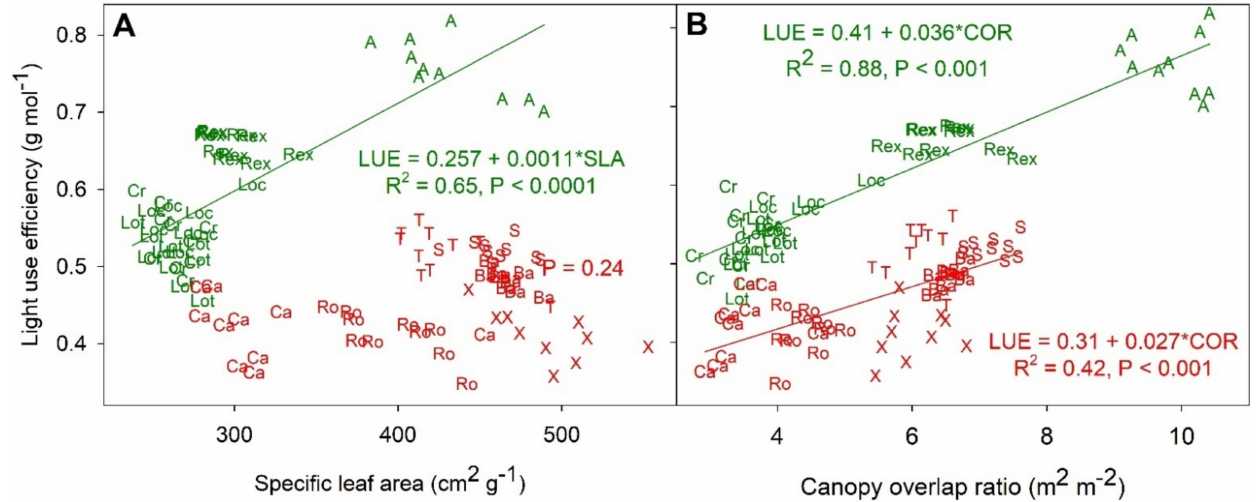
Figure 8. Correlation between light use efficiency and specific leaf area ( A ) and canopy overlap ratio ( B ) at harvest 51 days after germination. R 2 , p -value, and regression equation or only p -value are shown adjacent to a regression line when significant. Letters correspond to cultivars (‘Aquino’ (A), ‘Barlach’ (Ba), ‘Carmessi’ (Ca), ‘Crunchita’ (Cr), ‘Locarno’ (Loc), ‘Lotus’ (Lot), ‘Rex’ (Rex), ‘Rouxai’ (Ro), ‘Seurat’ (S), ‘Teodore’ (T), and ‘Xandra’ (X)), while text color indicates red and green lettuce